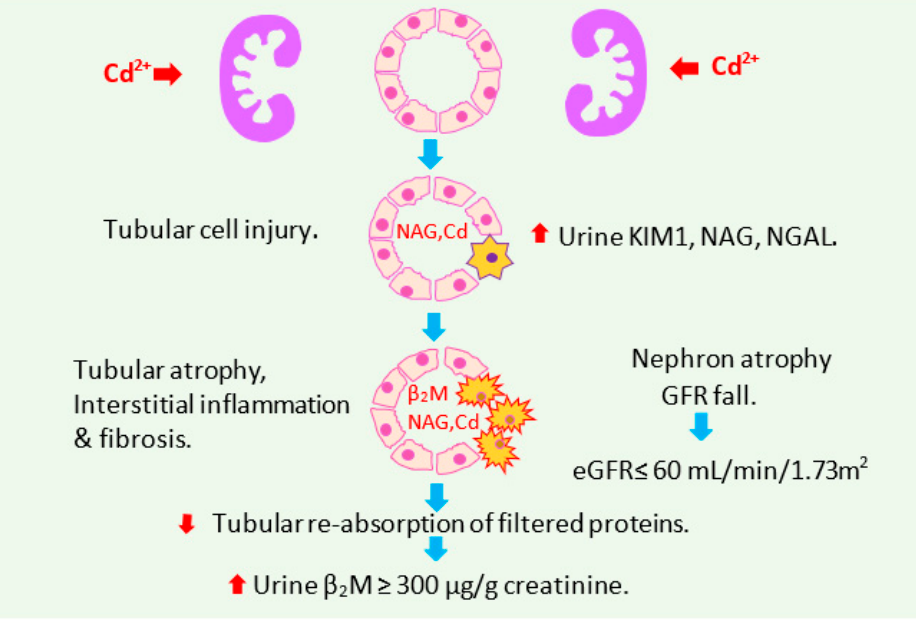
Figure 1. Sequential outcomes of tubular cell toxic injury of cadmium accumulation in kidneys. Cd inflicts tubular cell injury at low intracellular concentrations, and the toxicity intensifies as Cd con- centration rises [40]. Tubular injury disables glomerular filtration, causing nephron atrophy, glo- merulosclerosis, and interstitial inflammation and fibrosis [40,55,56]. A reduction in tubular reab- sorption of filtered proteins, RBP and β 2 MG follows tubular atrophy and a substantial nephron loss. Abbreviation: KIM1, kidney injury molecule 1; NAG, N-acetyl- β -D-glucosaminidase, NGAL, neu-